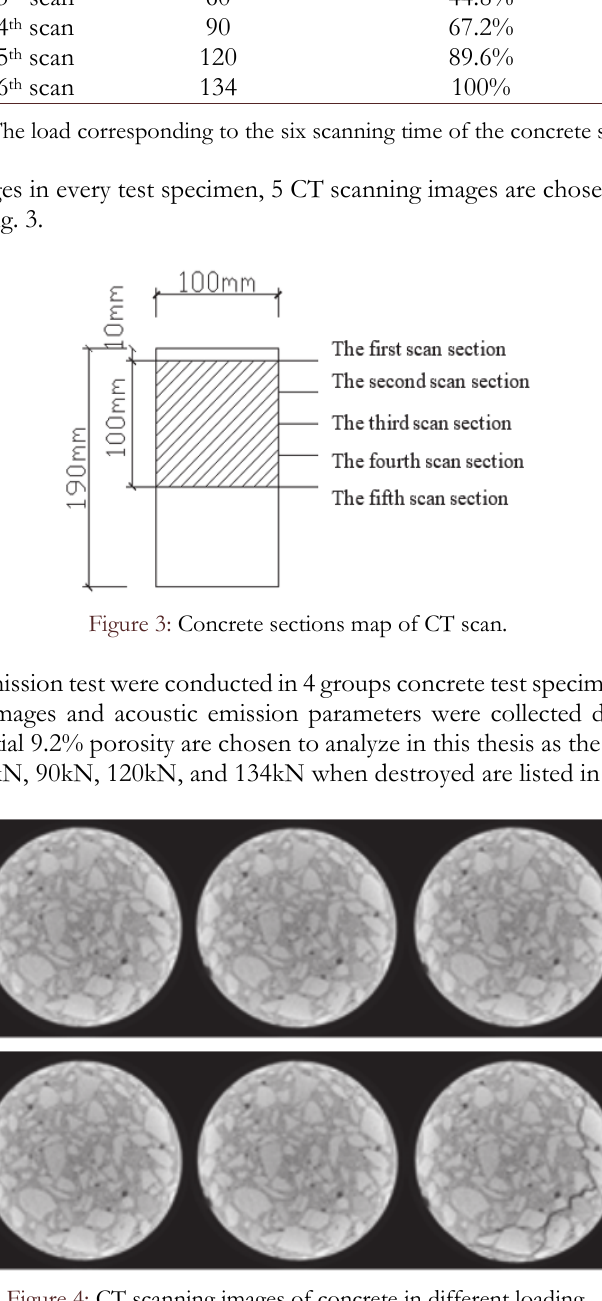
Figure 4: CT scanning images of concrete in different